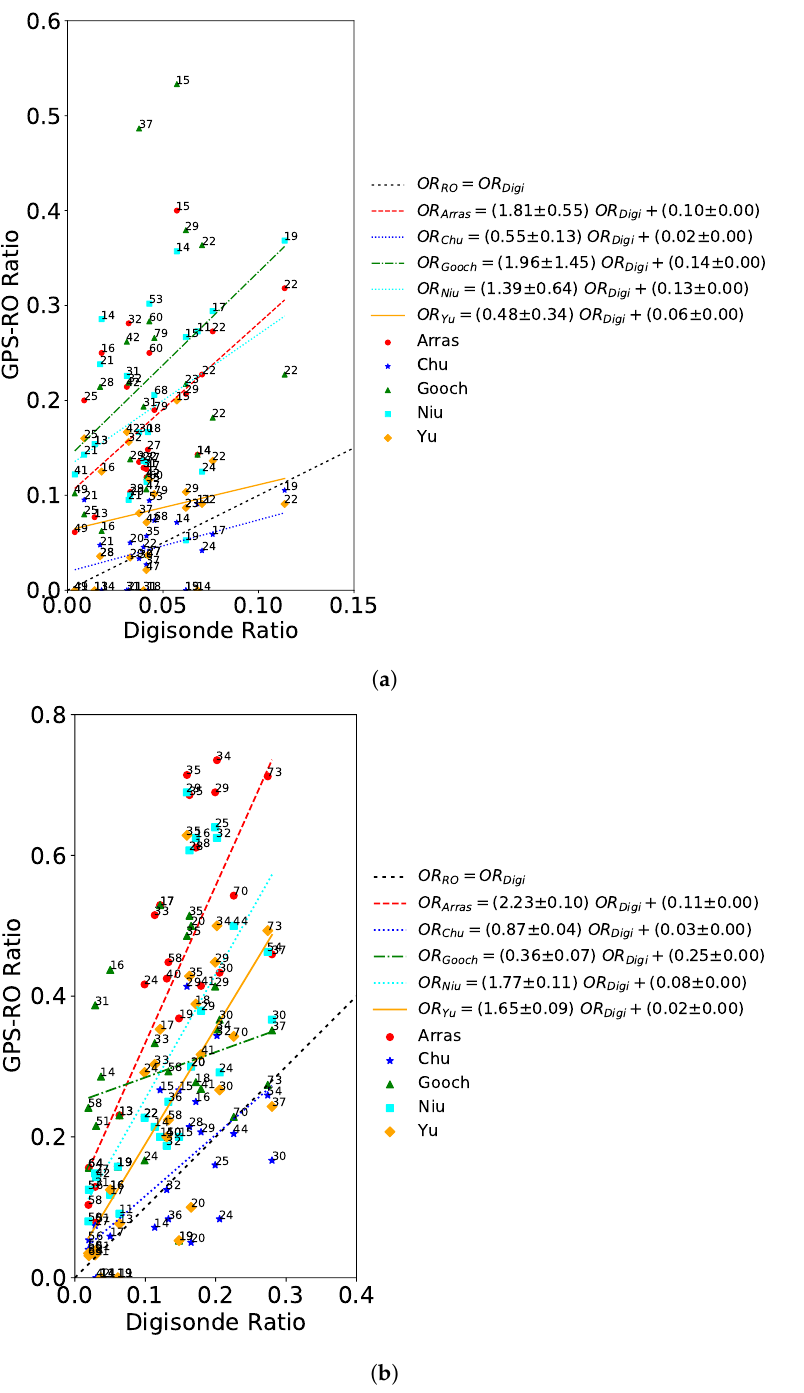
Figure 5. Same as Figure 2, but for fbEs ≥ 3 MHz. ( a ) December, January, and February 2010–2017. ( b ) June, July, and August